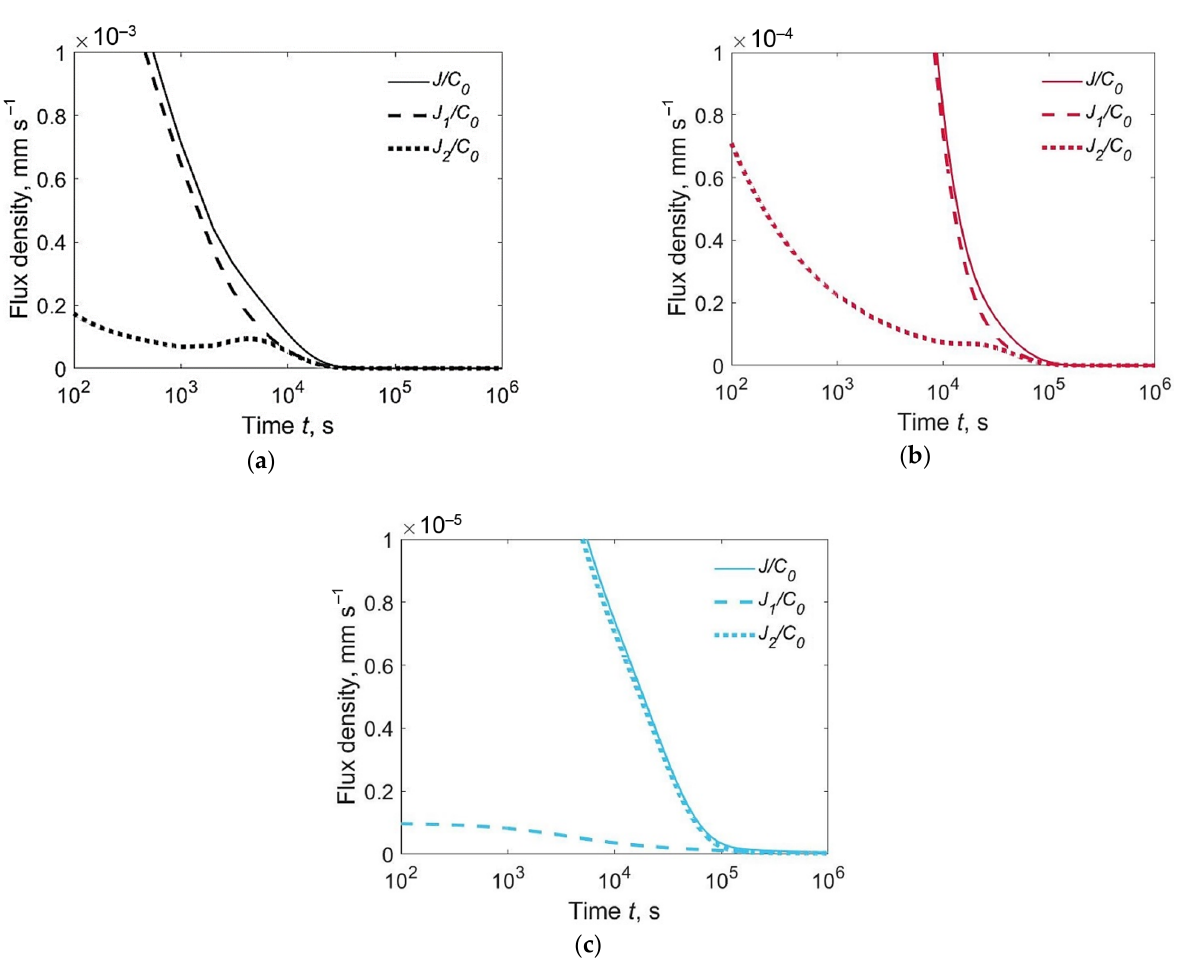
Figure 5. Relative flux density of hydrogen evolution from the upper surface J 1 / C 0 , lower surface J 2 / C 0 and both surfaces J / C 0 for welded joints of different types, C 02 / C 01 = 0.1: ( a ) F + F ; ( b ) F + M ; ( c ) A + M .